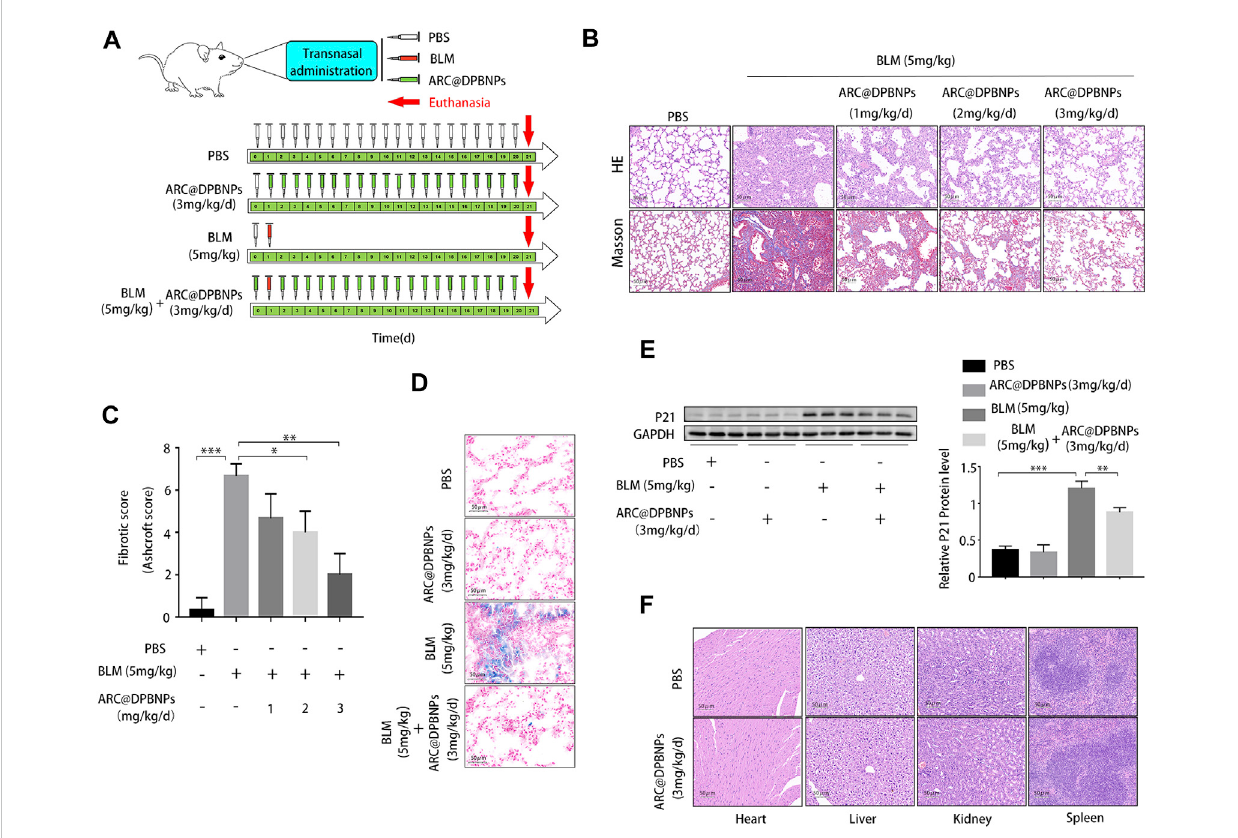
FIGURE 3 Effect and toxicity of arctiin-encapsulated DSPE-PEG bubble-like nanoparticles (ARC@DPBNPs) on pulmonary fi brosis in the mouse model (A) Schematic representation of the regimens of ARC@DPBNPs, phosphate-buffered saline, and bleomycin local pulmonary administration in mice (B) Representative photographs of lung sections of the pulmonary fi brosis in a mouse model treated with various ARC@DPBNP concentrations stained with hematoxylin – eosin (HE) and Masson ’ s trichrome (MA). Scale bar = 50 μ m. (C) Fibrotic scores were analyzed. (D) Representative results of senescence-associated ß -galactosidase staining of mice lung tissues. Scale bar = 50 μ m. (E) Senescent marker p21 in mice lung tissues measured through Western blotting. (F) Hematoxylin and Eosin staining of the heart, liver, spleen, and kidney performed after intrapulmonary administration of ARC@DPBNPs (3 mg/kg/d) for 21 d * p < 0.05, ** p < 0.01, *** p <